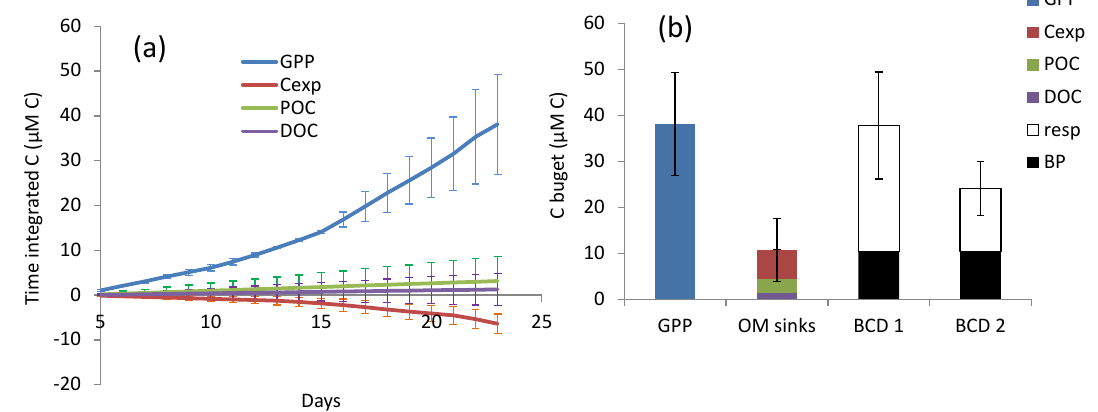
Figure 6. Carbon budget of the mesocosms with time (µMC). (a) Evolution of time-integrated gross primary production (GPP), C export in sediment traps (Cexp); time-integrated net POC and net DOC are calculated assuming linear fits of these variables between days 5 and 23 (see Table 3). (b) Budget of time-integrated data on day 23. The difference GPP – (Cexp + net DOC + net POC) was assumed to be community respiration (resp). The range of heterotrophic bacterial carbon demand (BCD) was calculated based on two hypotheses: BR = 100% CR (BCD 1) or BR = 50% CR (BCD 2). Standard errors are plotted from the sum of each category using propagation of